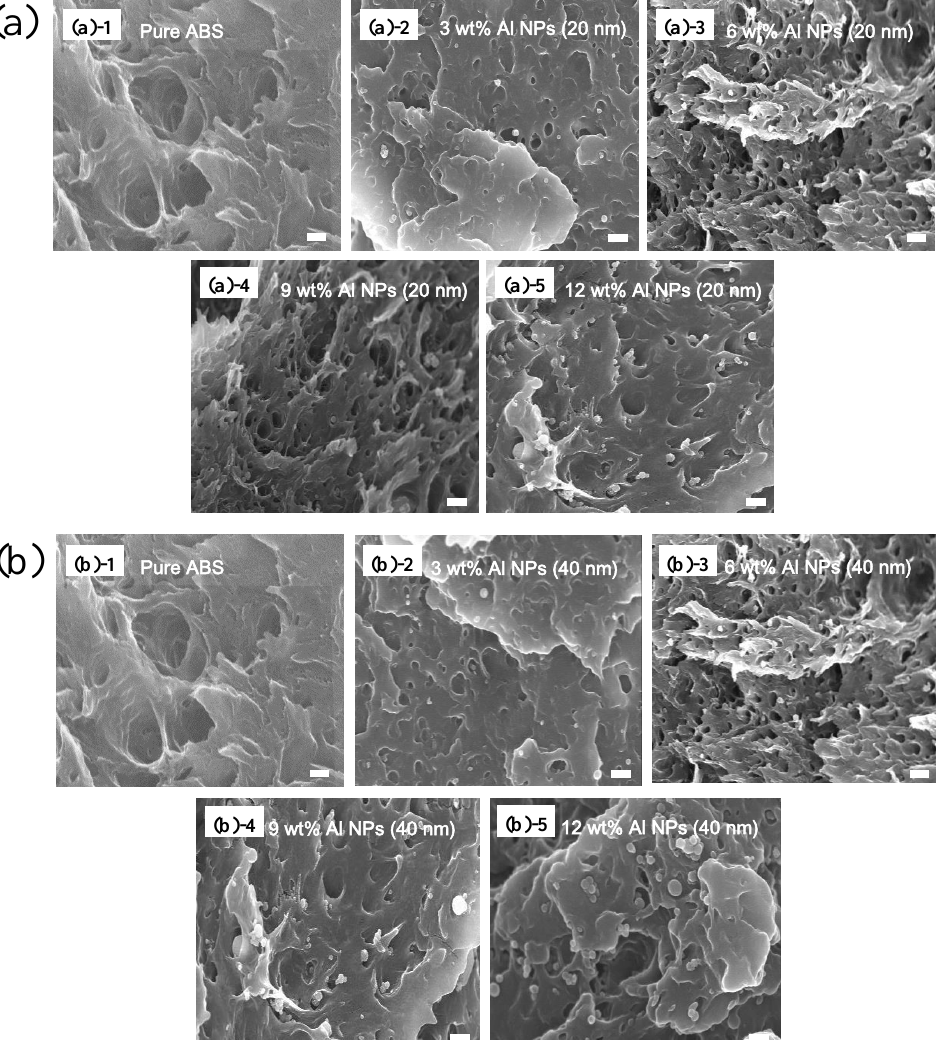
Figure 2. S. Jeong et al. 310